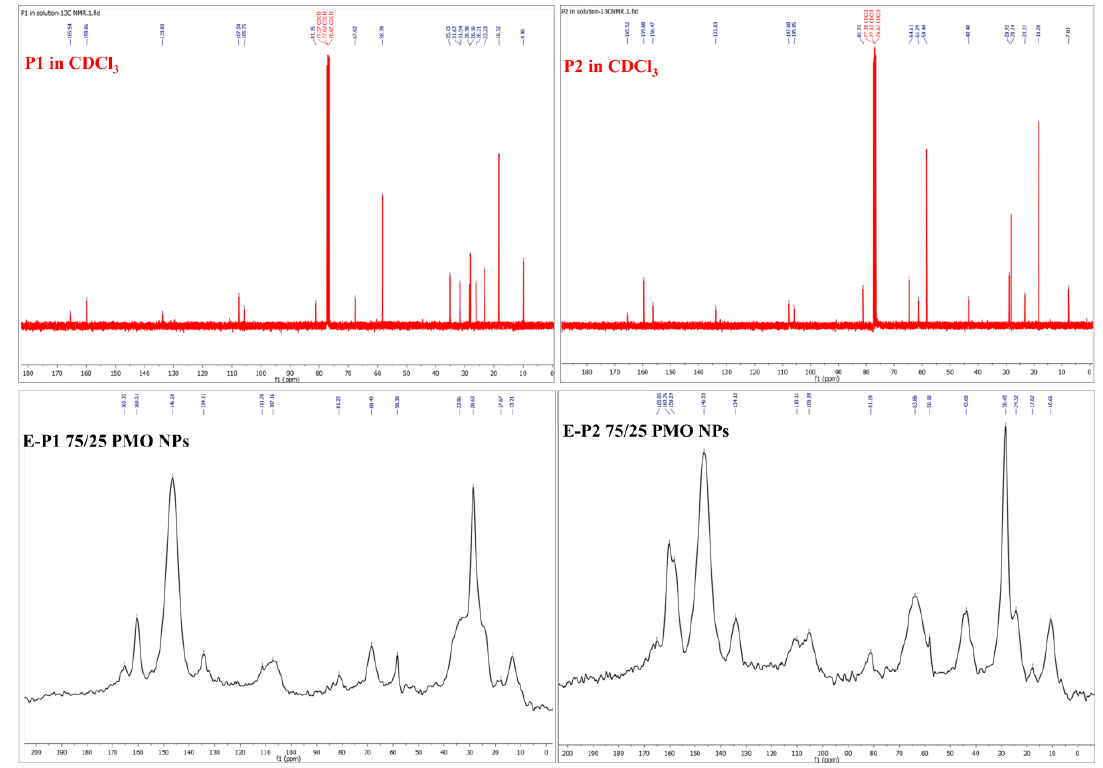
Figure 5. 13 C NMR of Pn in CDCl 3 (above) and 13 C CP MAS NMR of E-Pn 75/25 PMO NPs (below).